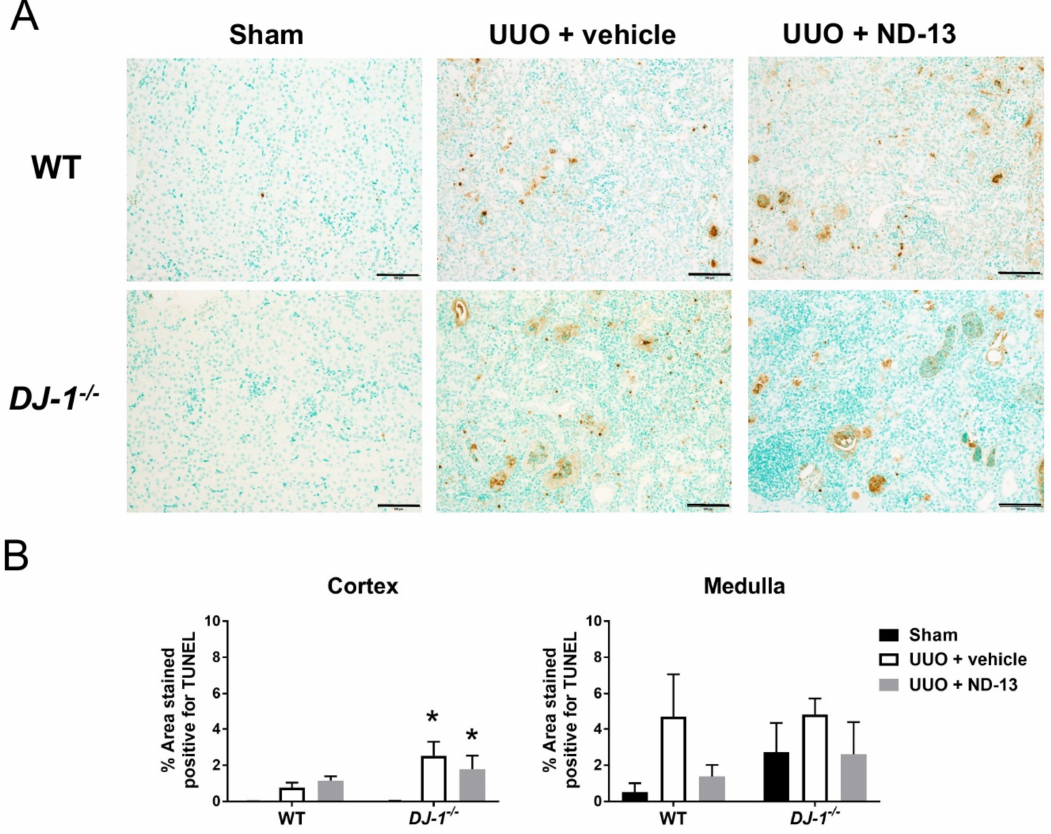
Figure 4. ND-13 does not protect against UUO-induced cell death. ( A ) Representative images of TUNEL stained (brown color) kidney cortex from WT (upper panels) and DJ-1 − / − mice that underwent sham surgery, UUO and vehicle treatment or UUO and ND-13 treatment (scale bar = 100 µ m). ( B ) Quantification of cell death (% TUNEL-positive area) in kidney cortex and medulla of WT and DJ-1 − / − mice that underwent sham surgery, UUO and vehicle treatment or UUO and ND-13 treatment. n = 4–5 / group; * p < 0.05 vs. same genotype sham, two-way ANOVA with Tukey’s post-hoc